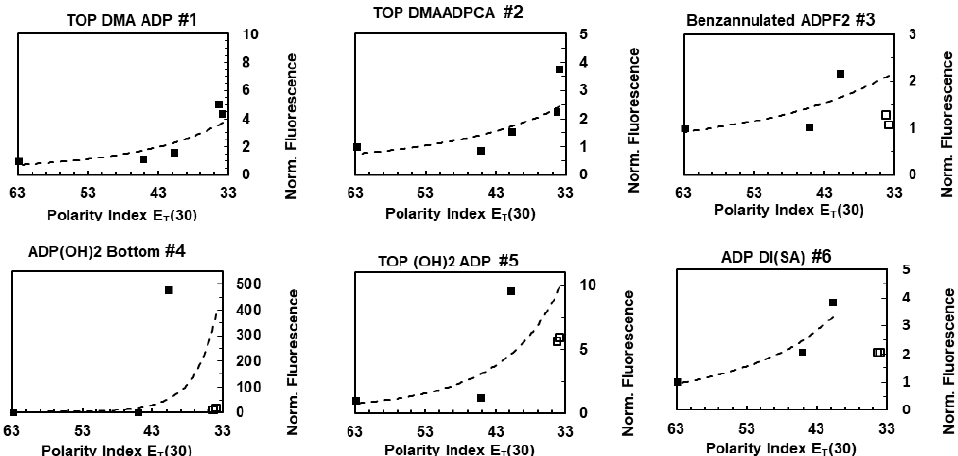
Figure 3. Peak fluorescence emission signal intensity vs solvent polarity. Power function fitted to the points depicted with black squares. The fluorescence intensity in water is normalized to 1. The significant decrease in the fluorescence intensity from the highest polarity value, observed for fluorophores 3, 4, 5 and 6 in benzene and toluene (the last two squares) might be due to lower solubility in highly nonpolar solvents. Since we are only interested in the response to polarity, the points in which the fluorescence intensity was affected by solubility were shown with hollow squares and not included in fitting. To limit the effect of solubility, very low concentrations (50 nM) were used, and no aggregation was observed. In general, the fluorescence emission intensity of all the fluorophores increased with the decrease in polarity. The existence of amine groups attached to the fluorophore system seems unnecessary for generating a strong polarity-sensitive probe. As such, fluorophore 4 is a highly sensitive probe, despite not having an amine group. In the case of fluorophores with substitutions of electron-donating groups to the aryl rings attached to the core of the fluorophore, polarity sensitivity was most prominent when the hydroxyl groups were attached to the para position of aryls at 3- and 5- (fluorophore 4), and to a lesser degree, when hydroxyl groups were attached to the meta position of the aryls at 1- and 7- (fluorophore 5), or when the sulfonate groups were attached to the aryls at 3- and 5- positions (fluorophore 6). More conclusive results were obtained by synthesizing Pluronic nanoparticles embedded with the fluorophores.